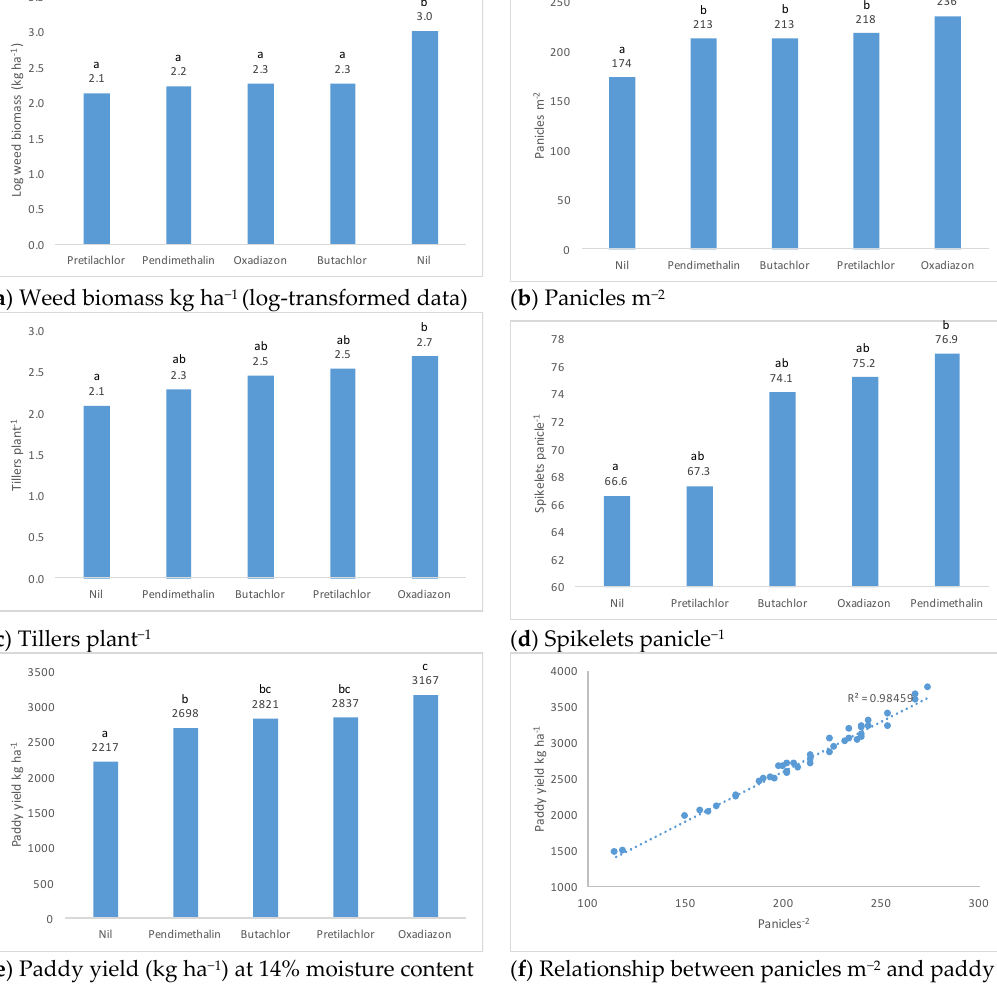
Table 6. Effect of seeding rate on rice yield components in 2018.